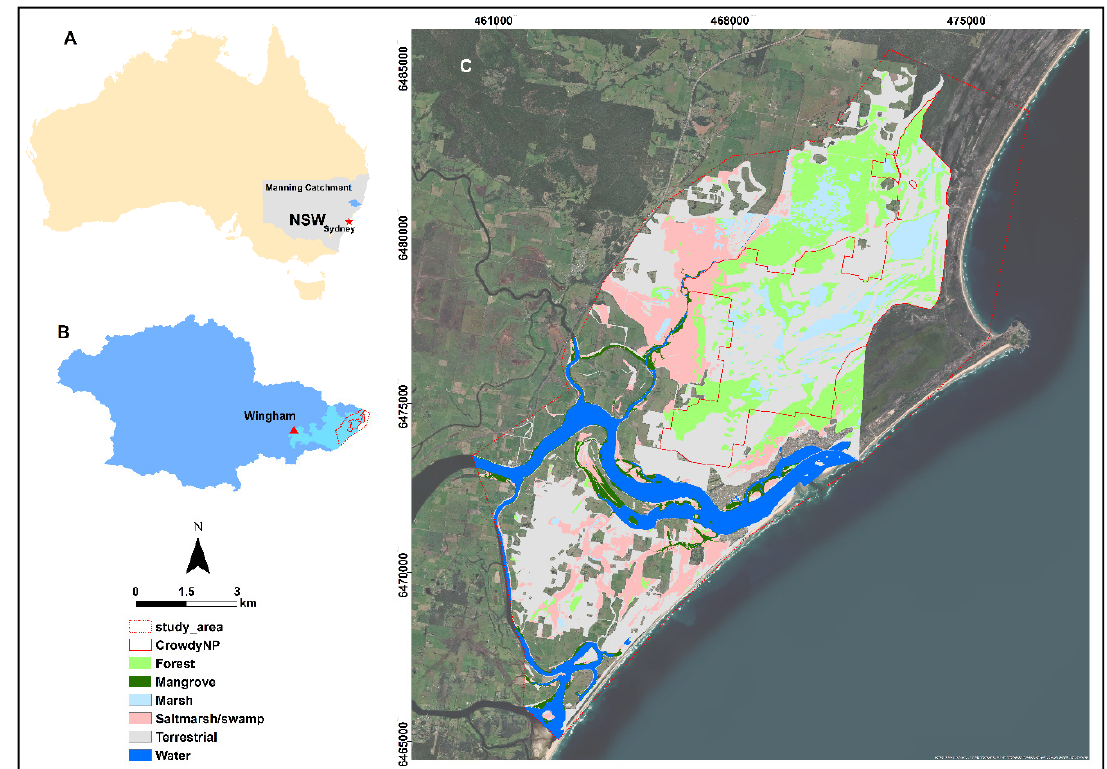
Figure 1. ( A ) A map showing the Manning River catchment situated in NSW, Australia. ( B ) A map of the Manning River Catchment showing the extent of the Manning Estuary and where Crowdy Bay National Park is situated. ( C ) The mapped wetland types in the focused study area simplified from the existing wetlands map in [40]. The terrestrial vegetation includes the lightly grazed native vegetation. The background aerial photo shows the surrounding grazing and croplands, and proximity of the focused study area to the saline waters of the lower estuary.